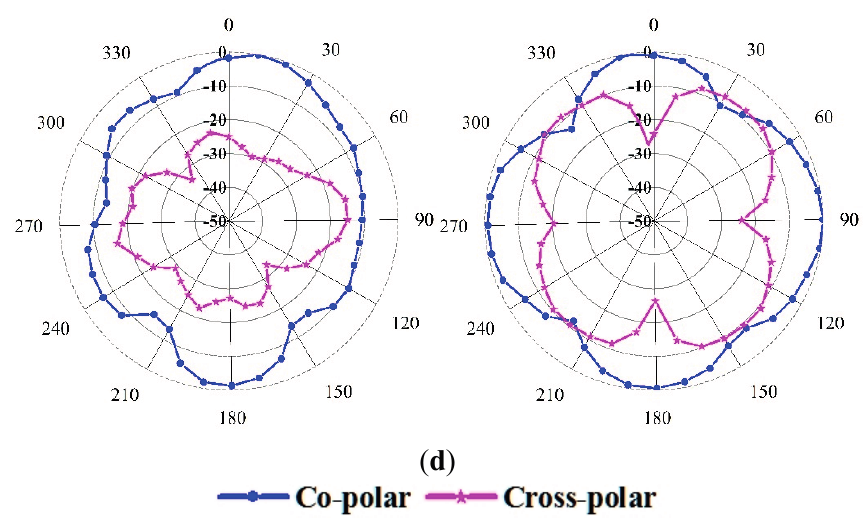
Figure 16. The measured radiation pattern at ( a ) 4 GHz; ( b ) 6 GHz; ( c ) 8 GHz; ( d ) 10 GHz. The surface current distribution of the proposed MTM UWB antenna at frequencies 4, 6, 8 and 10 GHz are shown in Figure 17. It is observed that the unit cells on the patch, microstrip line and rectangular slots at the top edge of the partial ground plane played important roles for creating resonances and achieving UWB frequency bands with a negative index metamaterial. In particular, the microstrip line and slotted ground plane had major effects at 4, 6, 8 and 10 GHz. At the top edge on the patch, there were strong effects due to the 1st and 4th unit cells at 4 GHz; 1st , 2nd, 3rd, and 4th unit cells at 6 GHz; 1st, and 4th unit cells at 8 GHz; and 1st, 2nd, 3rd unit cells at 10 GHz. This ensures that the performance of this UWB antenna depends on the unit cells on the patch, the feeding, and the rectangular slots at the top edge on the partial ground plane. The surface current maintains a harmonic flow at both the patch and the ground plane, resulting in the generation of an ultra-wide frequency band by a negative index metamaterial.